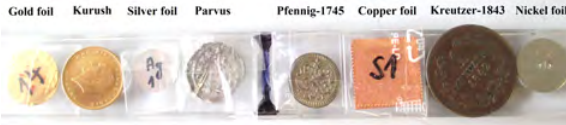
Figure 1. First set of historical samples with reference materials.